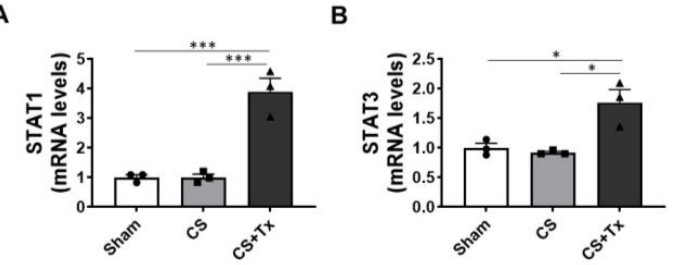
Figure 3. Cold storage plus transplantation induces STAT1 and STAT3 genes. Sham, 18 h CS, and 18 h CS + Tx groups underwent mRNA extraction and quantitative real-time PCR (SYBR Green) to assay the expression of ( A ) STAT1 and ( B ) STAT3. Data are the mean ± SEM (bars, n = 3), compared via 1-way ANOVA followed by Brown – Forsythe and Welch’s corrections for multiple group comparisons; p < 0.05 considered significant comparing Sham vs. CS + Tx and CS vs. CS + Tx groups. *, p < 0.05; ***, p < 0.001. Each solid circle, square, or triangle represent individual animals within the group.